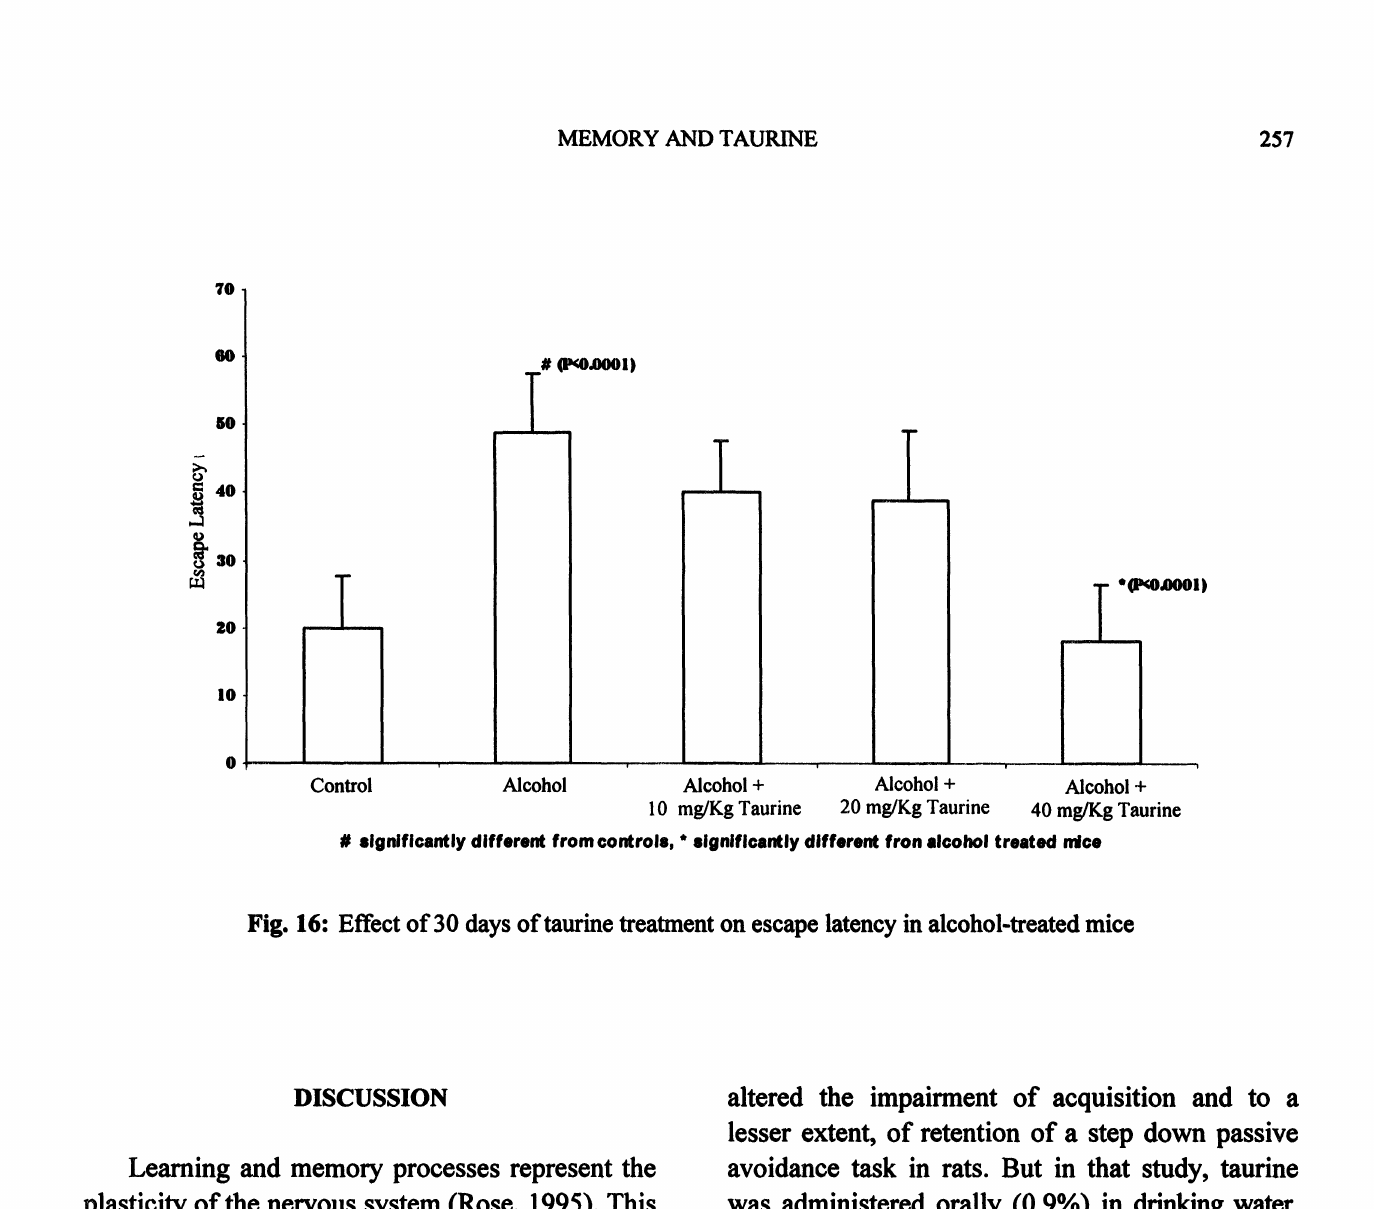
Fig. 16: Effect of 30 days oftaurine treatment on escape latency in alcohol-treated